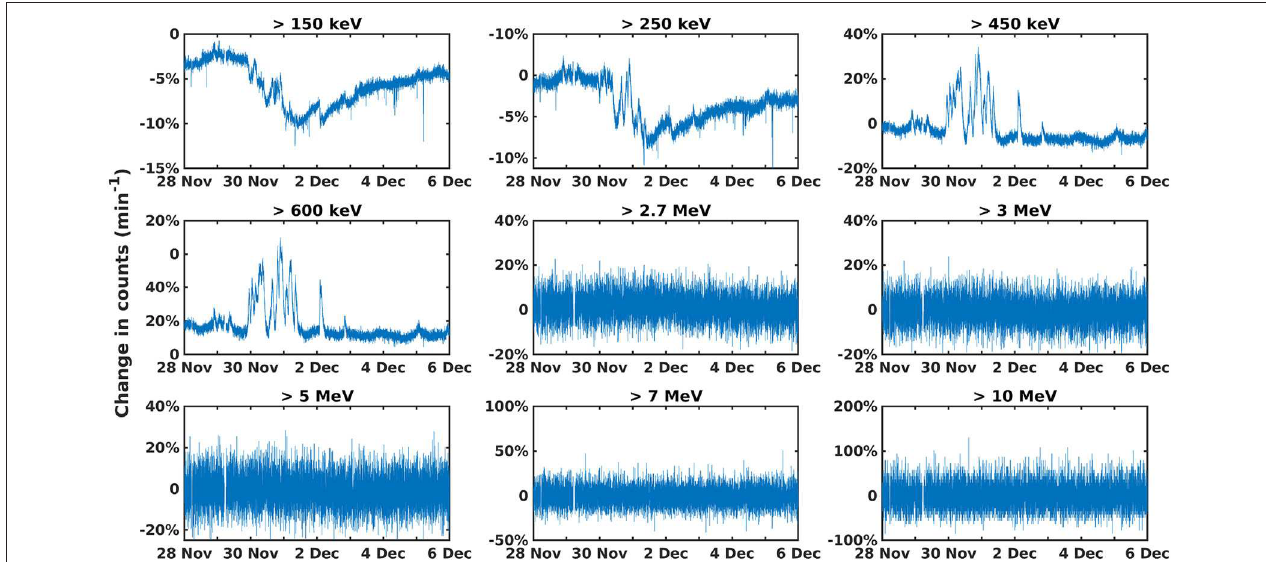
FIGURE 6 | Total nine energy cut-off ranging from ∼ 150 keV to ∼ 10 MeV are plotted in subplots with energy indicated above the subplot. γ -ray data for the time duration from 28 November to 5 December 2017 is depicted. Percentage decrease/increase is indicated on y-axes.